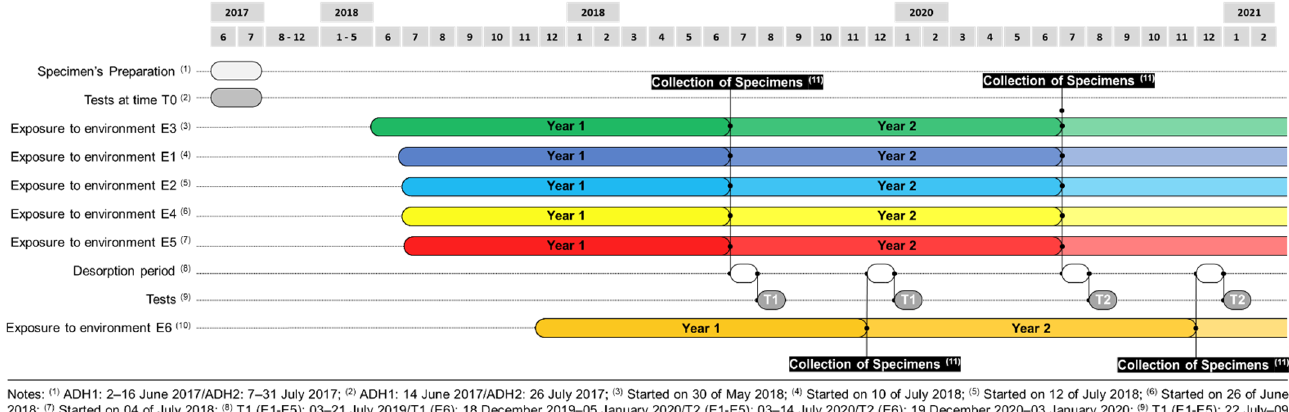
Figure 3. Timeframe of the developed work.